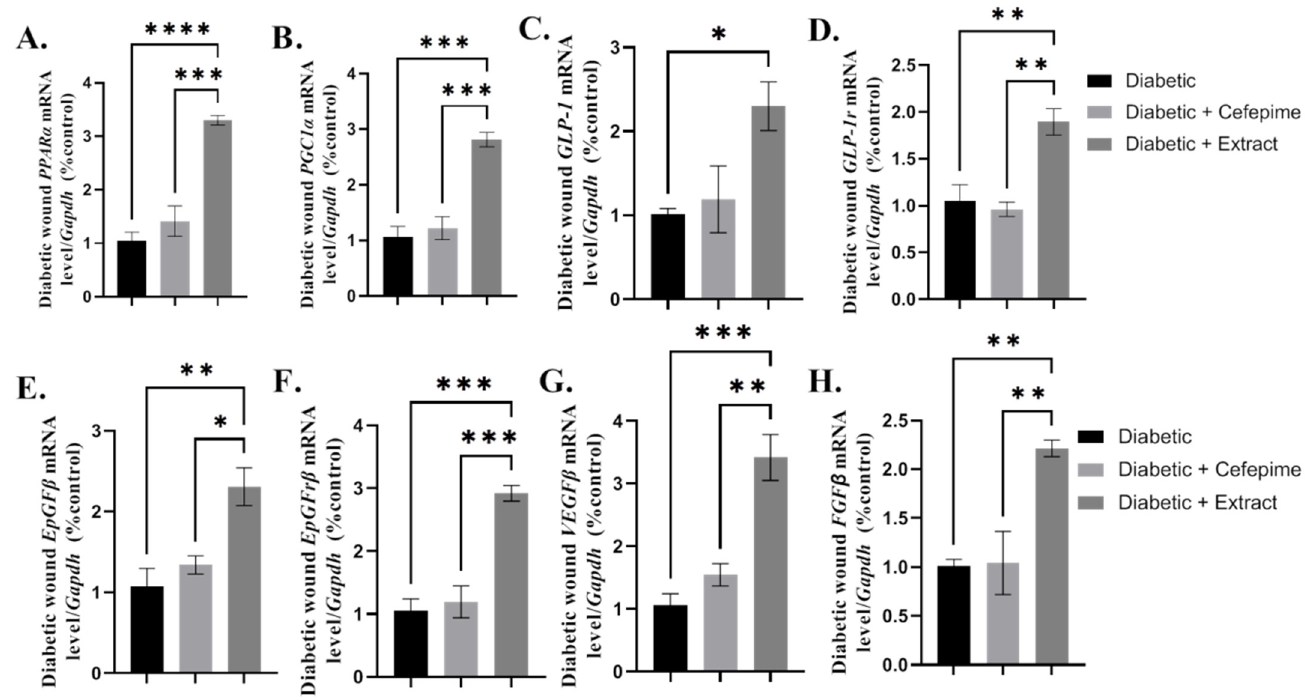
Figure 5. Effect of the hydrogel topical application of cefepime and CFE once daily for 14 successive days on the mean fold change of the mRNA relative expression of growth factors signaling pathway ( PPAR- α , PGC1- α , GLP-1 , GLPr-1 , EGF , EGFr , VEGF , and FGF ) to internal control gene Gapdh ( A – D ) and collagen deposition ( E , F ) of a diabetic wound infected with P. Mirabilis in Type 1 diabetic rats. ( A ) mRNA relative expression of PPAR- α to internal control gene Gapdh , ( B ) mRNA relative expression of PGC1- α to internal control gene Gapdh , ( C ) mRNA relative expression of GLP-1 to internal control gene Gapdh , ( D ) mRNA relative expression of GLPr-1 to internal control gene Gapdh , ( E ) mRNA relative expression of EGF to internal control gene Gapdh , ( F ) mRNA relative expression of EFGr to internal control gene Gapdh , ( G ) mRNA relative expression of VEFG to internal control gene Gapdh, and ( H ) mRNA relative expression of FGF to internal control gene Gapdh . **** very distinctive difference; *** Distinctive difference; ** Moderate difference; * Scant